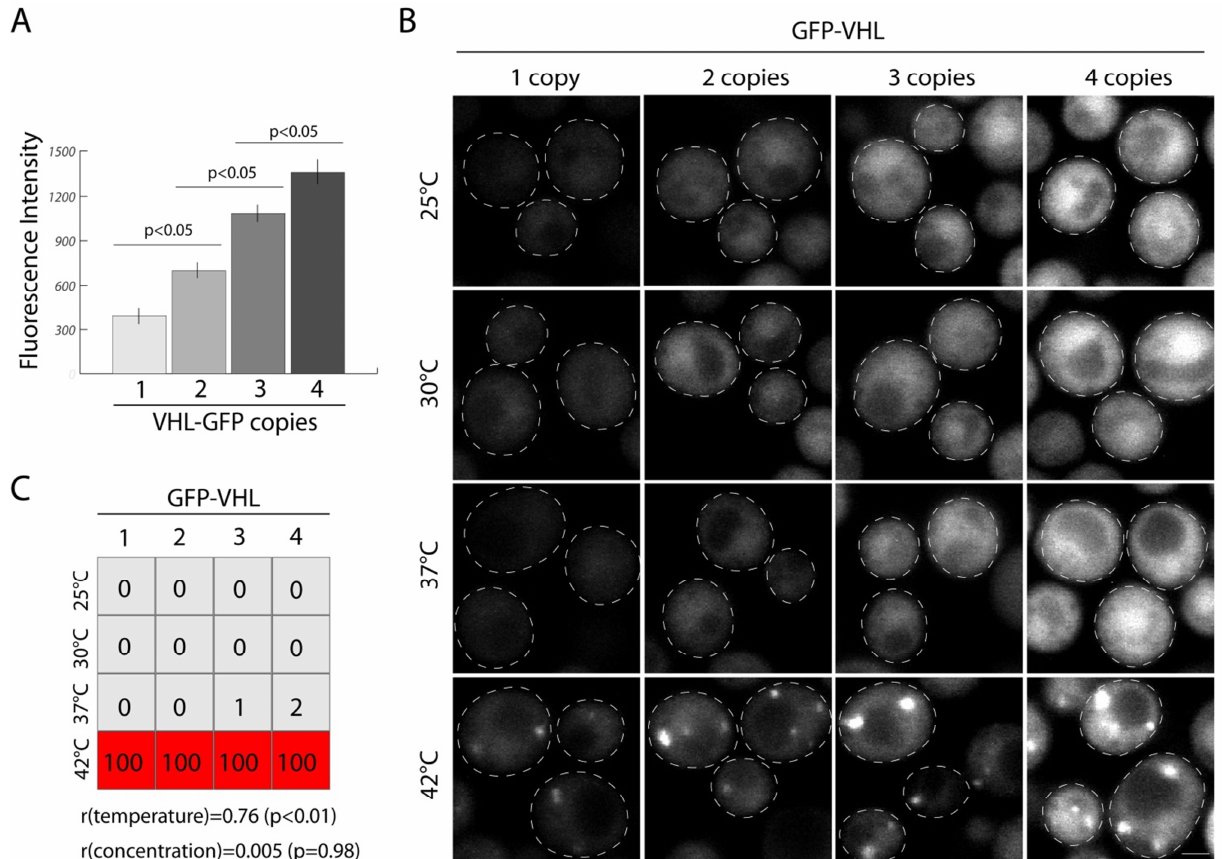
FIGURE 3: Proof of concept - Concentration does not correlate with inclusion formation. ( A) Gradual increase in the amount of GFP-VHL according to integrated copies, Fluorescence Intensity was quantified in 30 single cells in the population, the average and standard errors are represented on the graph. (B) Confocal images of cells carrying 4 copies of GFP-VHL on pDK-AC, TC, UC, HC modules subjected to the range of temperatures for 1h, scale bar 1 µm. (C) Quantification of inclusion forming cells in the population according to the change in the temperature and the concentration, the numbers represent % of the cells with inclusions (n = 300), correlation coefficient of aggregation and temperature (r(temperature)) and aggregation and concentration (r(concentration)) is provided under the